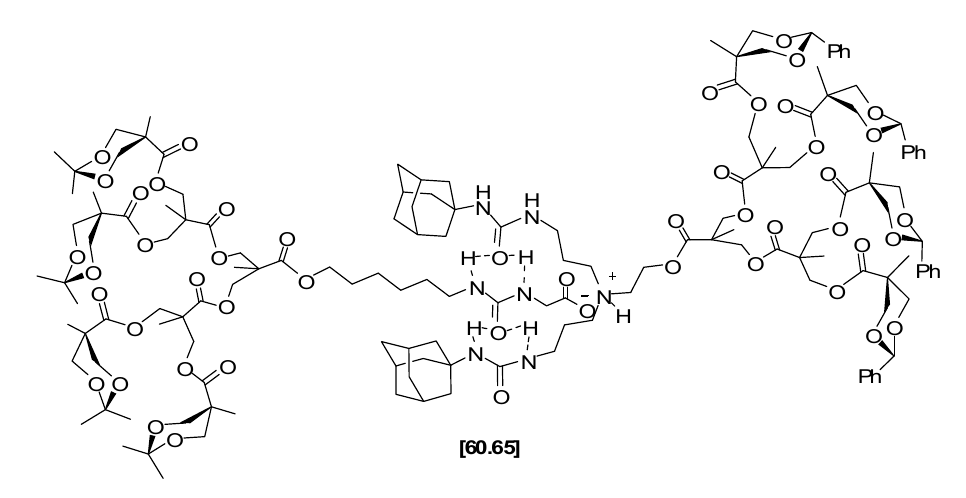
Figure 4. Orthogonally-protected parent dendrimer complex